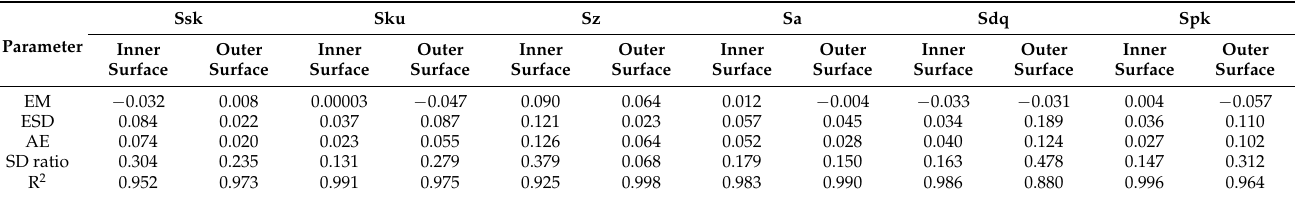
Table 9. Regression statistics of the ANNs analysed *.